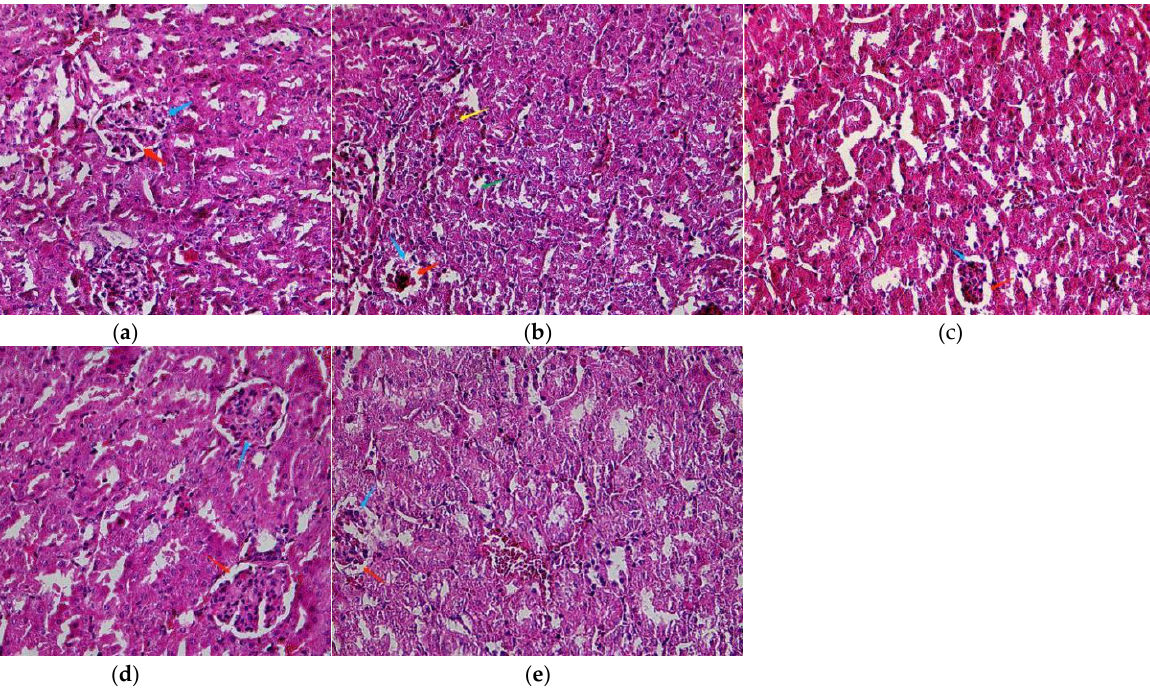
Figure 2. Light micrographs of the kidney cortex. ( a ) Control; ( b ) model; ( c ) low dose; ( d ) middle dose; ( e ) high dose. Glomerulus (blue arrow), urinary space (red arrow), damaged renal tubules with vacuolated cytoplasm (green arrow), and inflammatory cells in the interstitial tissue (yellow arrow). Original magnification: 400.